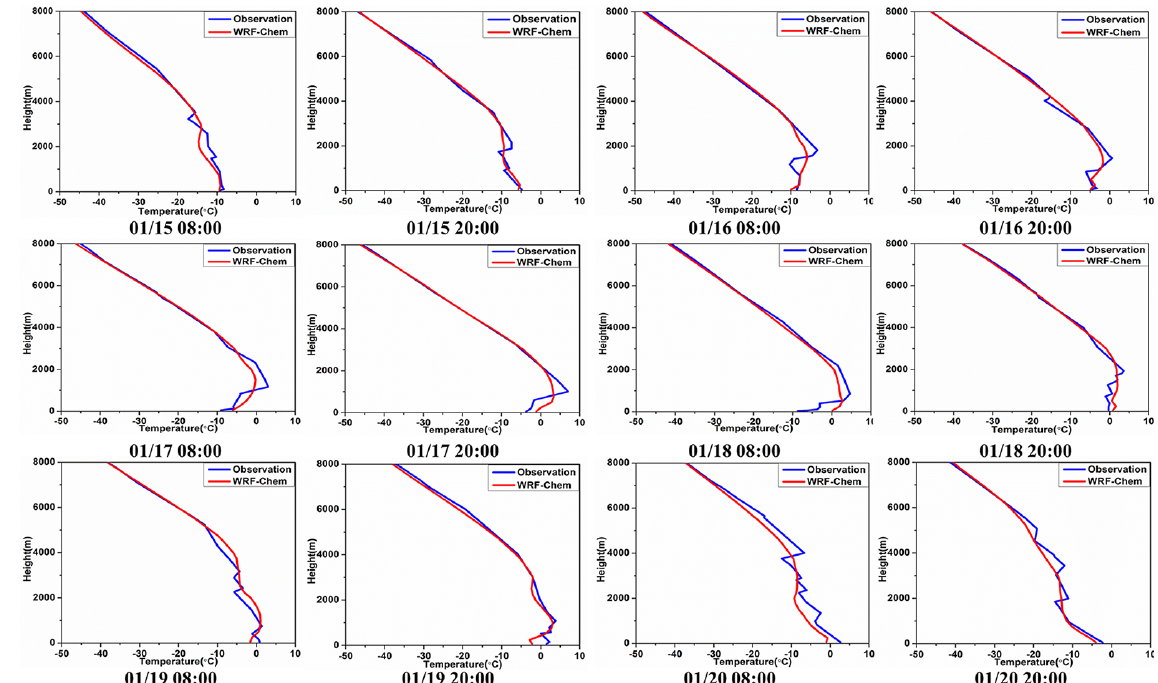
Figure 2. Simulated and observed vertical temperature profiles at 08:00 and 20:00 (China Standard Time, CST) from 15 to 20